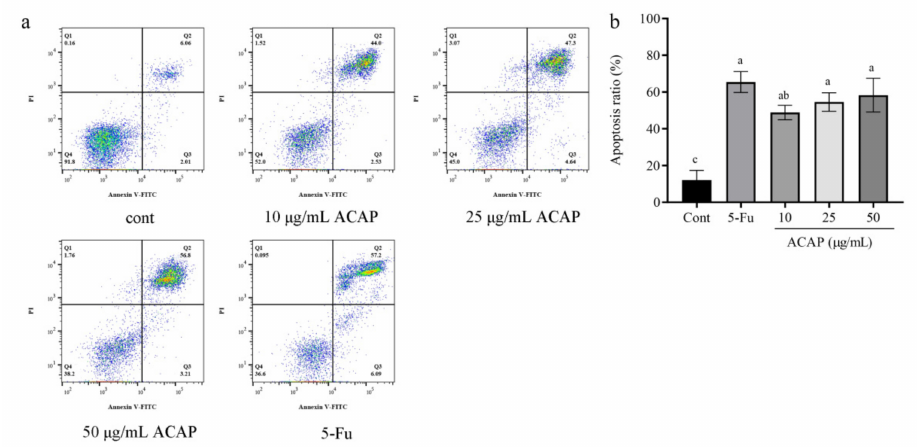
Figure 4. Effects of ACAP at three concentrations, and of controls, on Hep G2 apoptosis. ( a ) Analyzed by flow cytometry with Annexin V-FITC/PI double staining; ( b ) apoptosis ratio. Notations as in Figure 3. Differing letters above bars indicate significant ( p < 0.05) differences according to Tukey’s multiple comparisons